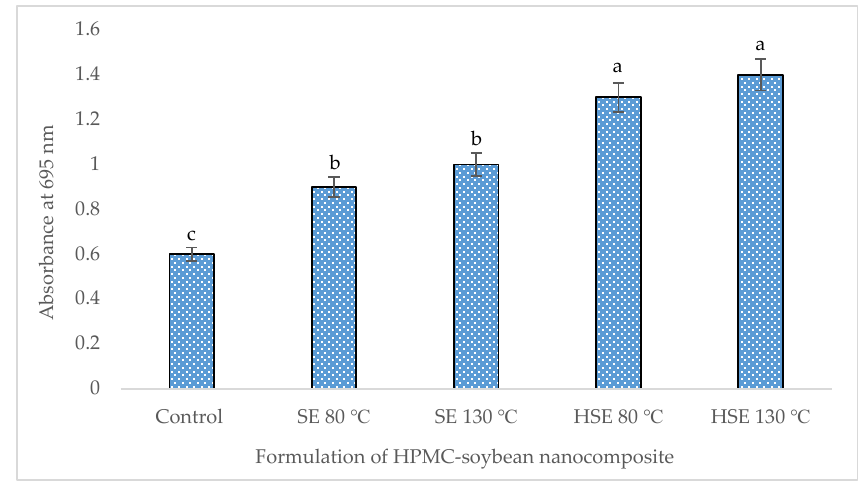
Figure 4. Reducing power of soybean-polymer composite (ferric reducing antioxidant power assay (FRAP assay)). Mean values ± SD from triplicate separated experiments are shown. Control: non- extrudate soybean, SE: extrudate 100% soybean at a different temperature, HSE: soybean (95%) + HPMC (5%) extrudate at a different temperature.